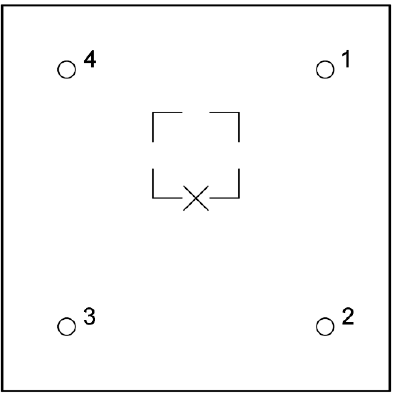
Detected Y—Yes, N—No, W—Warning.